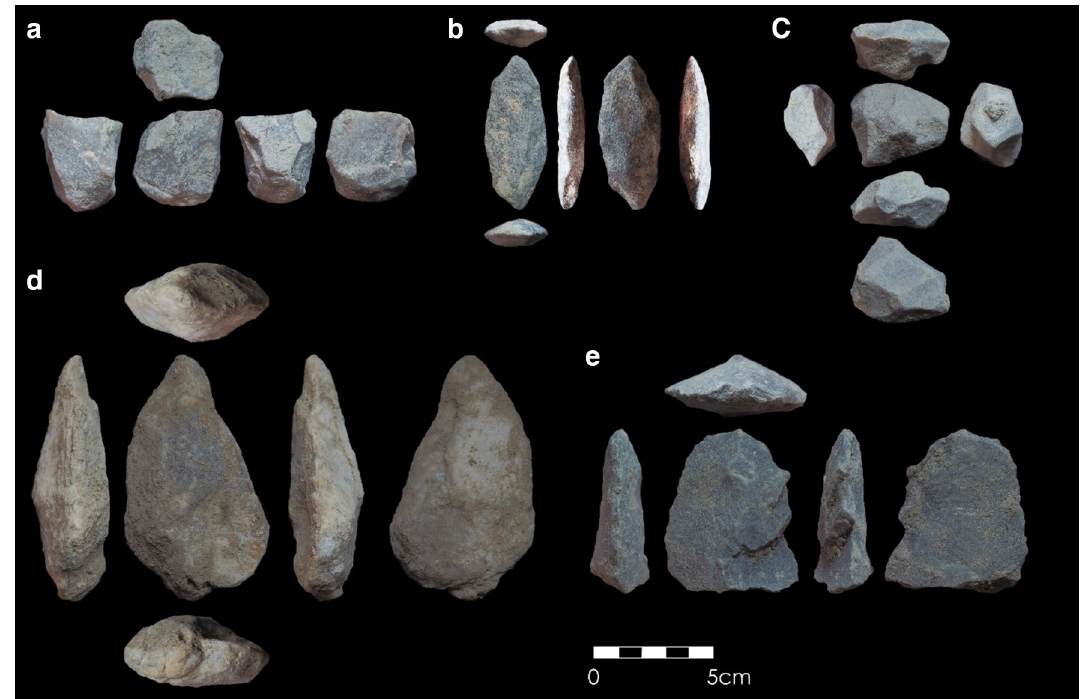
Figure 3. Artefacts recovered during new investigations at Singi Talav, including (a) multi-platform core (Layer 2); (b) bifacially retouched flake (Layer 3); (c) discoidal core (Layer 4); (d) biface with invasive removal (eroding from quarry edge); (e) finely retouched flake (eroding from quarry